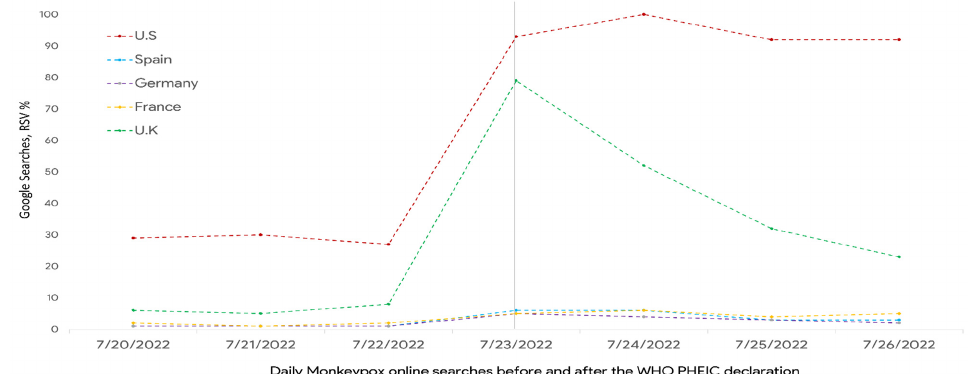
Figure 1. Monkeypox online searches three days before and just after the WHO declaration of Monkeypox outbreak as a Public Health Emergency of International Concern (PHEIC).